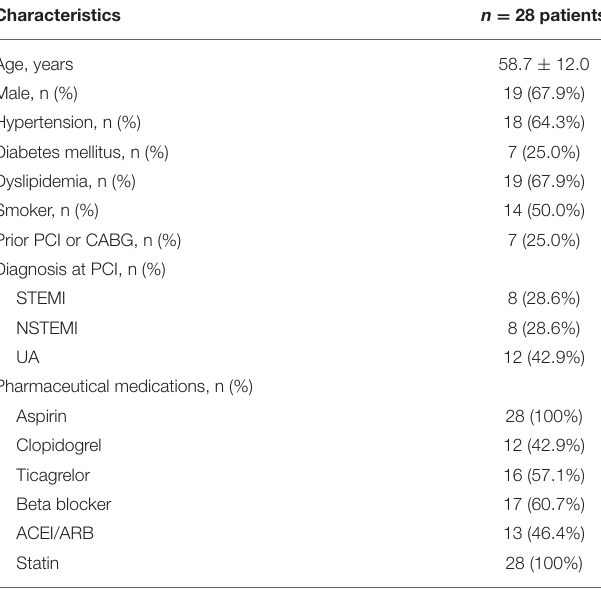
TABLE 4 | Clinical